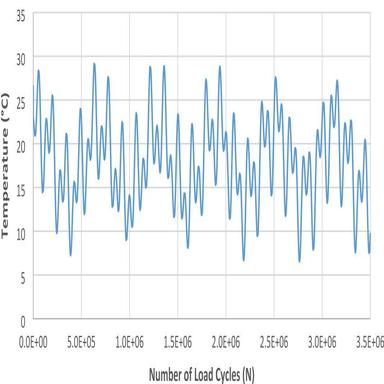
Hypothetical pavement temperature variation in the field.